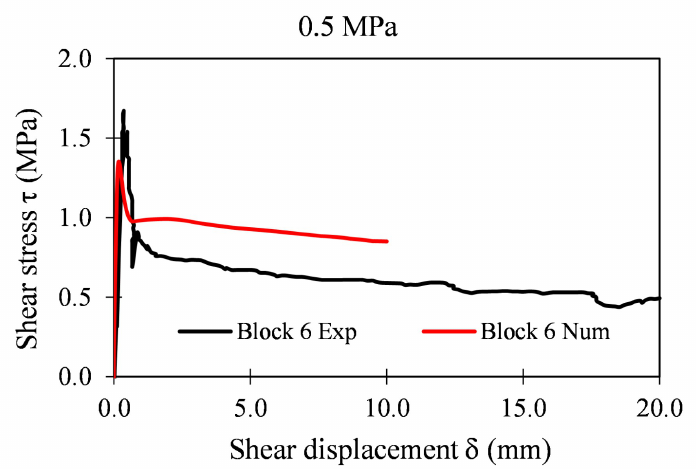
Figure 28. Shear stress evolution with displacement Exp–Num (Block 5).